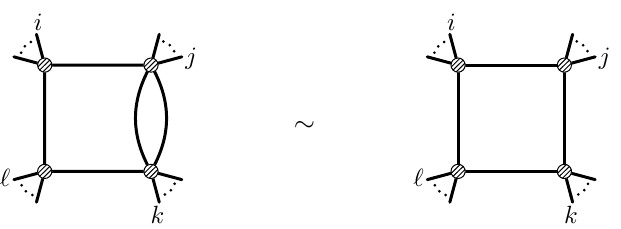
Figure 2 . The Landau equations of a Landau diagram containing a bubble are identical to the equations of a Landau diagram with one propagator of the bubble removed. The two-loop four- mass bubble-box on the left is the only Landau diagram with a four-mass box contributing to the branch points of the NMHV amplitude. It has the same well-known branch points as the one-loop four-mass box on the